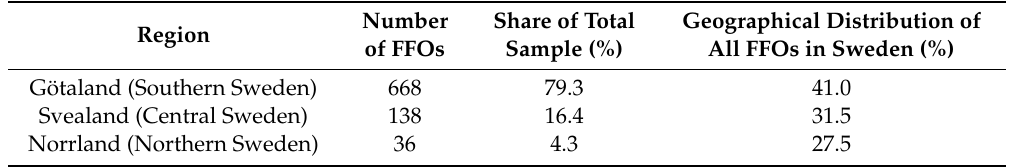
Table 1. Number and proportion of family forest owners (FFOs) in the sample in each region. For comparison, the geographical distribution of all Swedish owners (including those with properties < 6 ha) is also